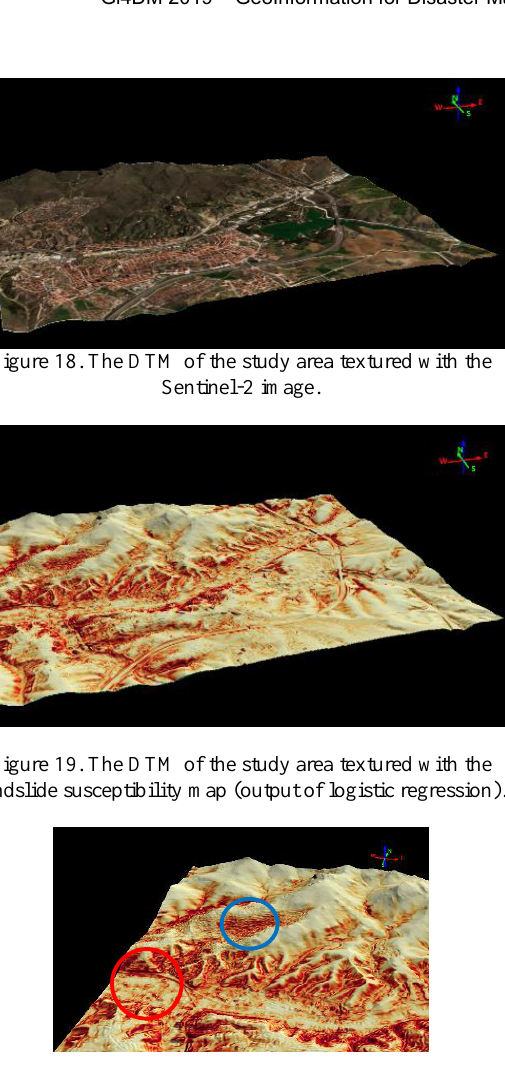
Figure 20. Important focal area for city planning in North- West Mamak.